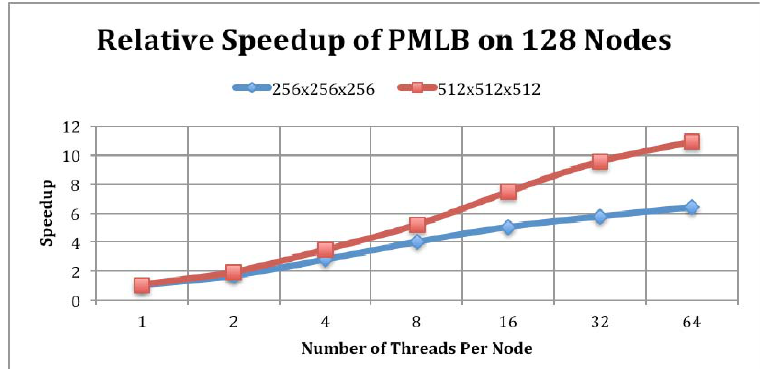
Figure 11. Performance comparison of PMLB on 128 Nodes with different number of threads per node